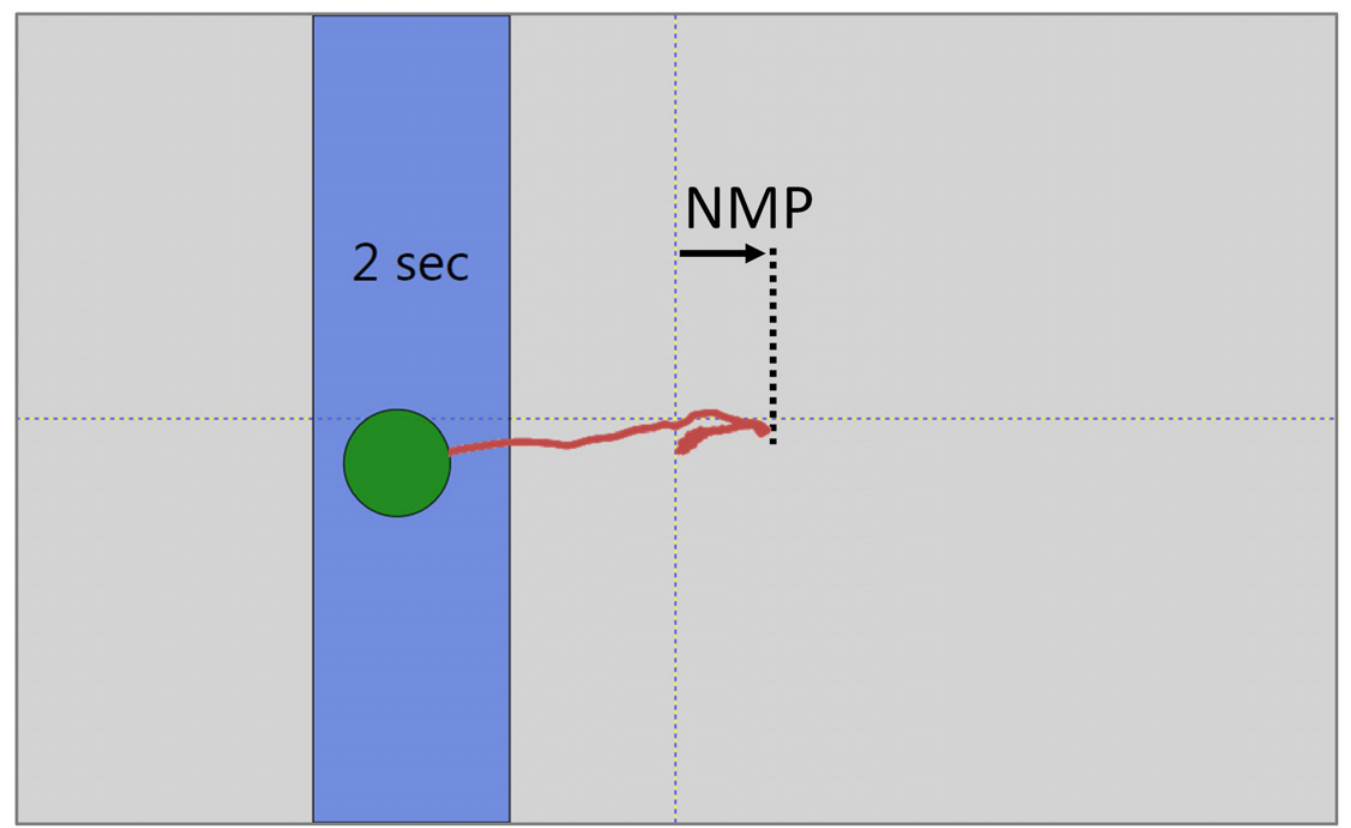
Fig 1. Non-Minimum Phase Behavior. As the subject shifts his/her position from the center to the blue target region on the left, his/her CoP first moves in the opposite direction due to the force required to initiate the weight shift, referenced in this and a previous study as NMP behavior. The red trace is not shown as a part of this study ’ s